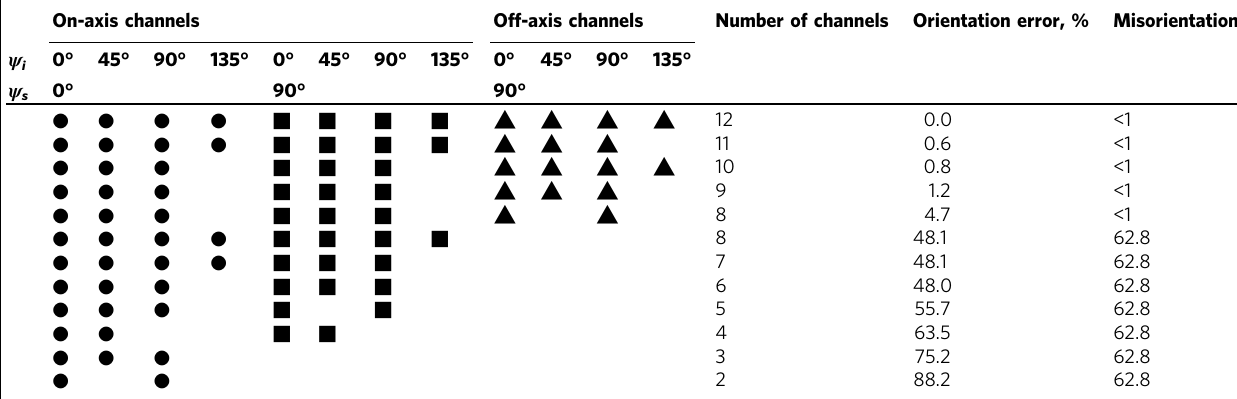
Table 1 Optimization of the orientation mapping con fi guration. Optimization results for different numbers of channels and channel polarization combinations. Orientation error percentage represents geometric area on the sample, where reliable fi t was achieved. Misorientation angle column represents ambiguity of the fi t; the chosen number of channels was nine (highlighted in the red